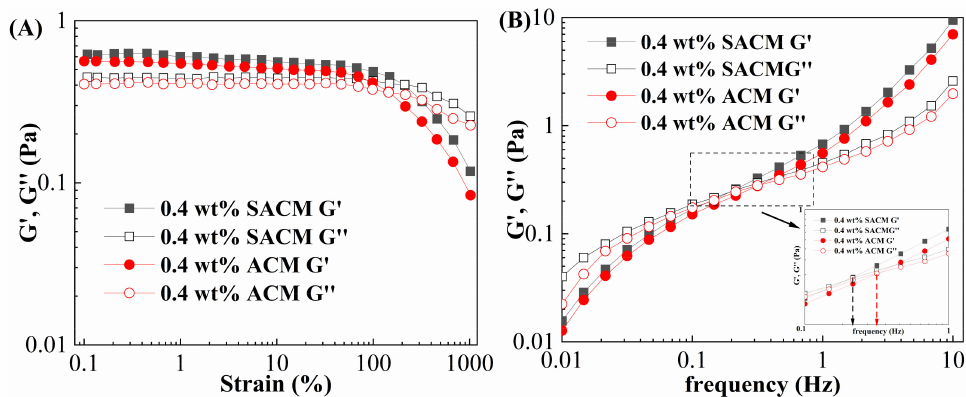
Figure 7. The viscoelasticity of suspension diluent and powder solution. ( A ) Strain scanning curve. ( B ) Frequency scanning curve.